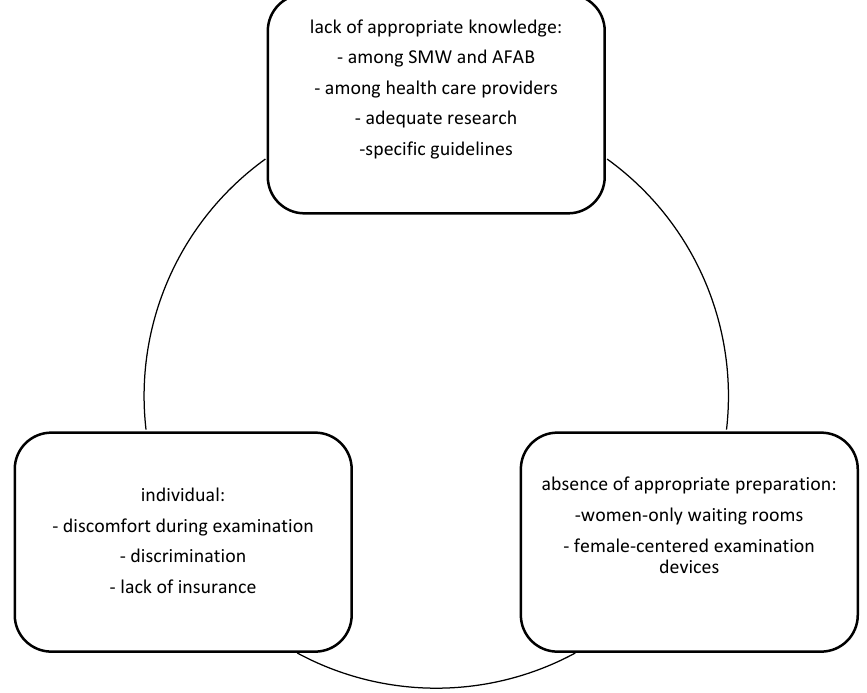
Figure 1. Cervical cancer screening barriers for SMW and AFAB.